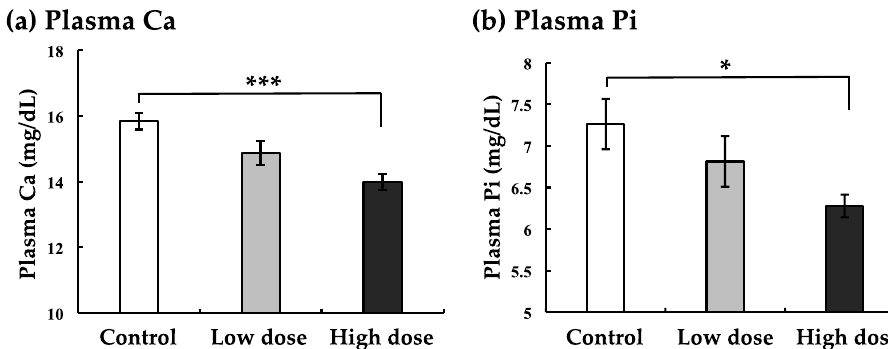
Figure 1. E ff ects of BaA on plasma calcium (Ca) ( a ) and inorganic phosphorus (Pi) ( b ) levels in BaA-treated or untreated nibbler fish. BaA (1 or 10 ng / g body weight) was injected intraperitoneally (four times) into nibbler fish for 10 days during breeding. Thereafter, plasma Ca and Pi levels were examined in the control and experimental groups. * and *** indicate statistically significant di ff erences at p < 0.05 and p < 0.001, respectively, from the values in the control scales (n = 8). The detection limits of Plasma Ca and Pi were 0.4 and 0.04 mg / dL, respectively.